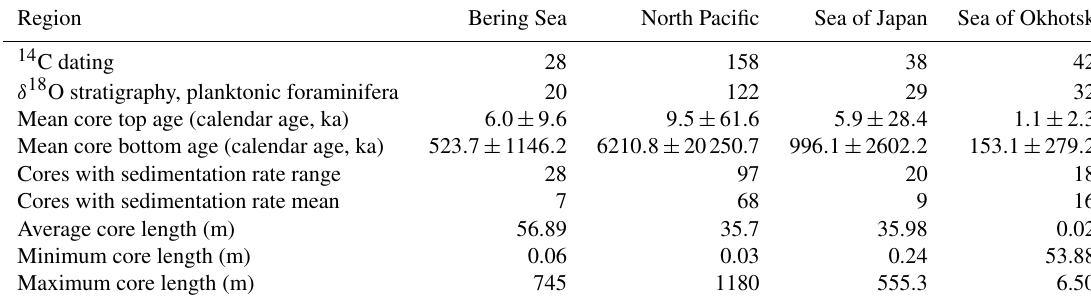
Figure 2. Age model development for sediment cores in the North Pacific and marginal seas. (a) Cores with age models that have been constructed with radiocarbon dating ( 14 C). (b) Number of paleoceanographic proxies used to generate each core’s age model. Table 3. Summary statistics on core chronology, including the number of cores with radiocarbon dating ( 14 C) and oxygen isotope stratigraphy of planktonic foraminifera ( δ 18 O), as well as the regional mean core top and bottom ages, the number of cores with published sedimentation rate ranges and means, and core length minimums, maximums, and averages. Region Bering